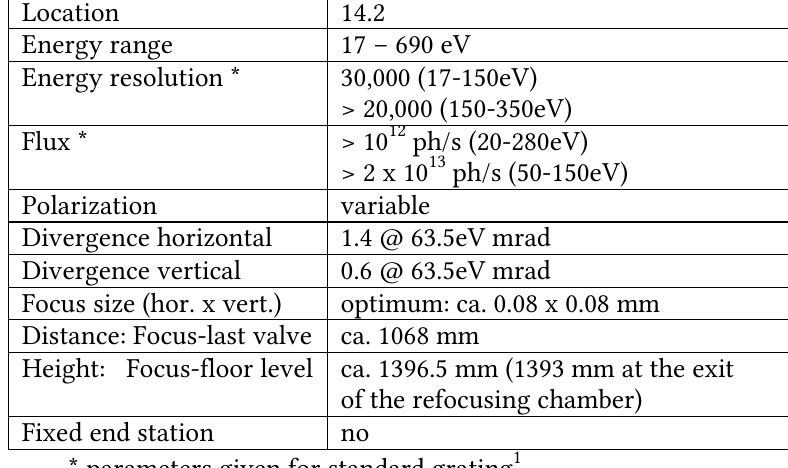
1 Savci A. & Schiwietz G. (2013). Actual measurements of beamline parameters have been performed in the years 2013 and